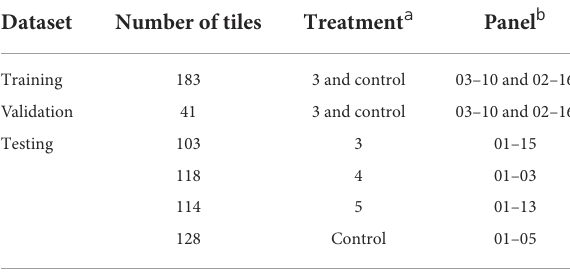
TABLE 1 Datasets for the segmentation of downy mildew